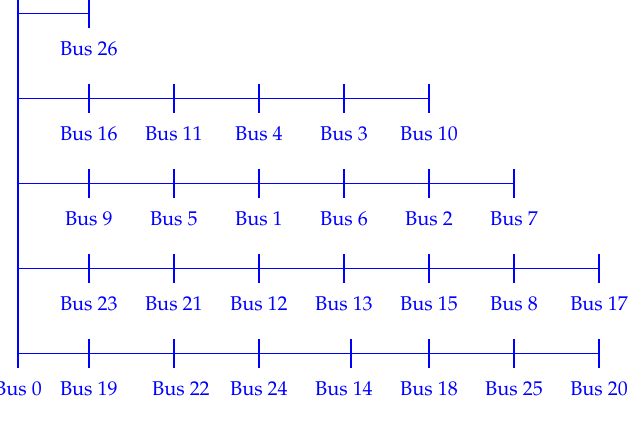
Figure 6. Case study: Distribution network [42].